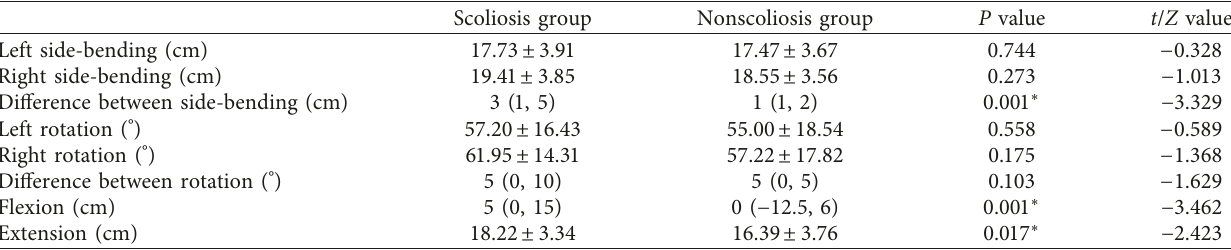
Table 3: Mobility of the lumbar spine in 3 planes in two groups.